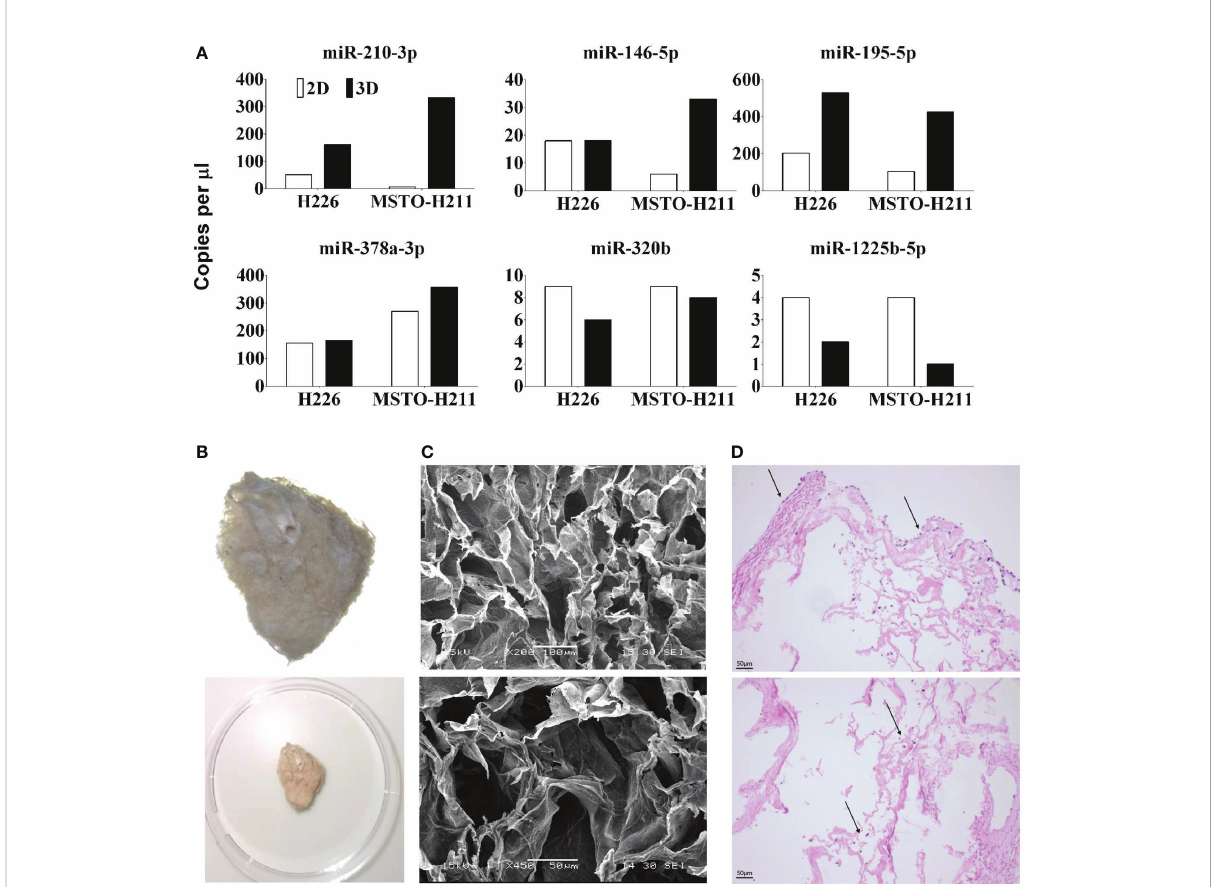
FIGURE 4 (A) miRNA expression quali fi ed by dd-PCR in 2D and 3D cultured H226 and MSTO mesothelioma cells. miR 210, 146, 195 and 378 are upregulated in 3D models and miR 320, 1225 are downregulated. (B) Decellularized lung scaffolds are used to grow primary mesothelioma cells (26). (C) Physical characteristics of decellularized lung scaffolds analysed by SEM. (D) Mesothelioma cells can be grown in decellularized lung scaffolds from both outside (top) and inside (bottom). Up to 14 days following seeding, the mesothelioma cells are continuing to grow around the decellularized lung scaffold.